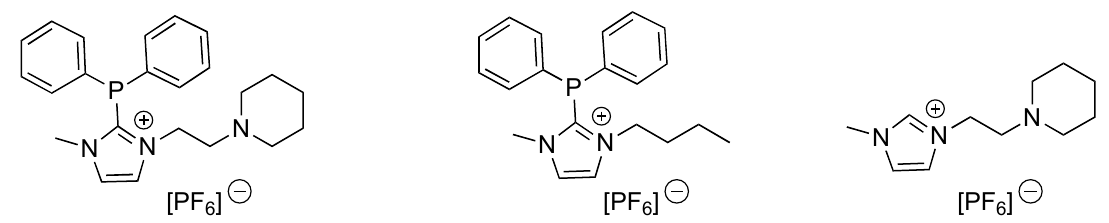
Figure 13. Mixture of monofunctionalized ILs.